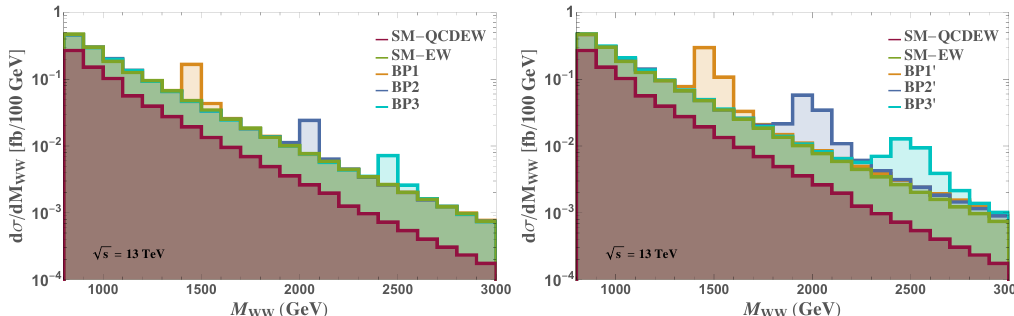
Figure 2 . Predictions of the cross sections times the branching ratios of the W bosons to hadrons, (cid:27) ( pp ! W + W (cid:0) jj ) (cid:2) (BR( W ! hadrons)) 2 , distributions with the invariant mass of the EW gauge boson pair, M WW , at the parton level, using MadGraph. The rates for the EW background (SM- EW), the mixed QCD-QED background (SM-QCDEW) and the selected signal scenarios for the vector resonances given by the BP’s de(cid:12)ned in table 1 are included. The cuts in eq. (3.1) have been